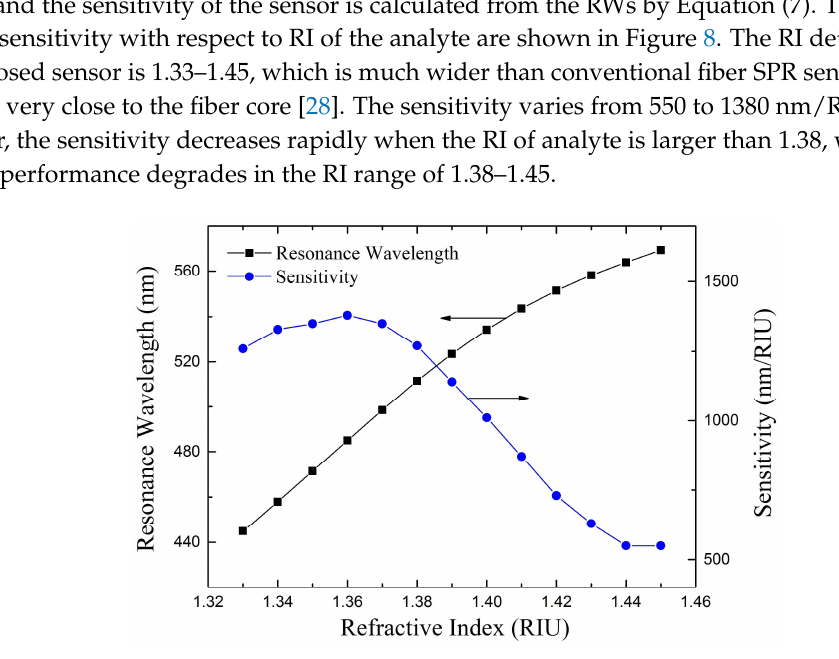
Figure 8. Theoretical results of resonance wavelength and sensitivity of the proposed sensor at λ 0 = 1000 nm, N = 4, d m = 35 nm.